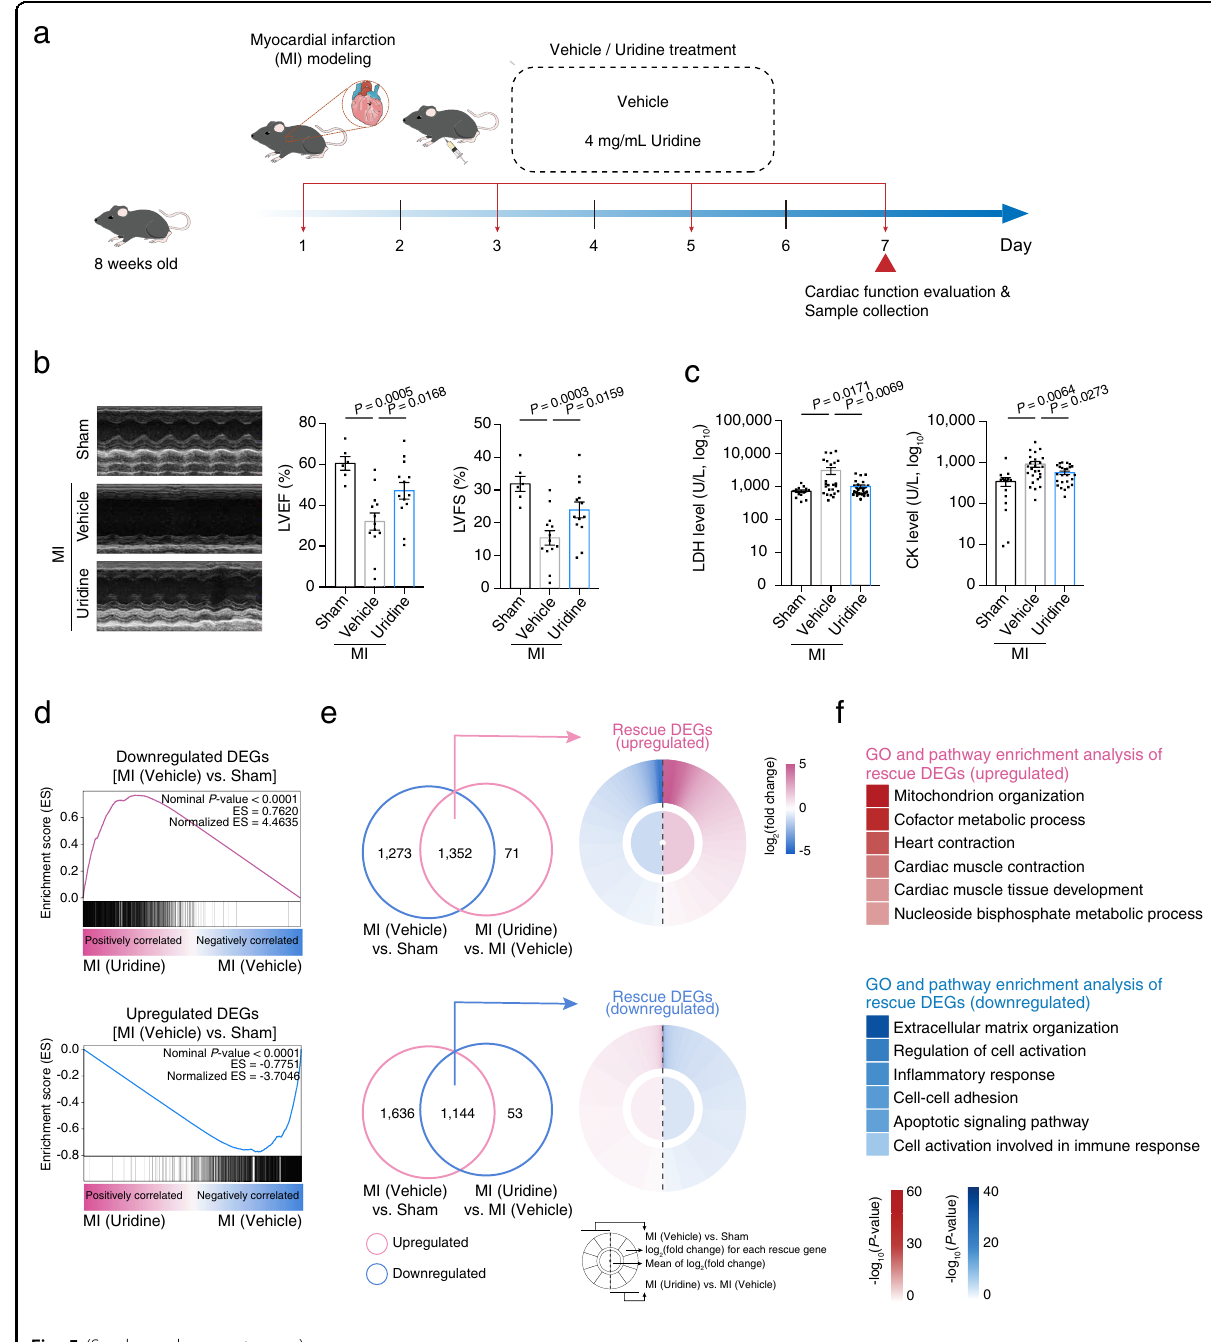
change)MI (Vehicle) vs. Sham log 2 (fold change) for each rescue gene Mean of log 2 (fold MI (Uridine) vs. MI (Vehicle)